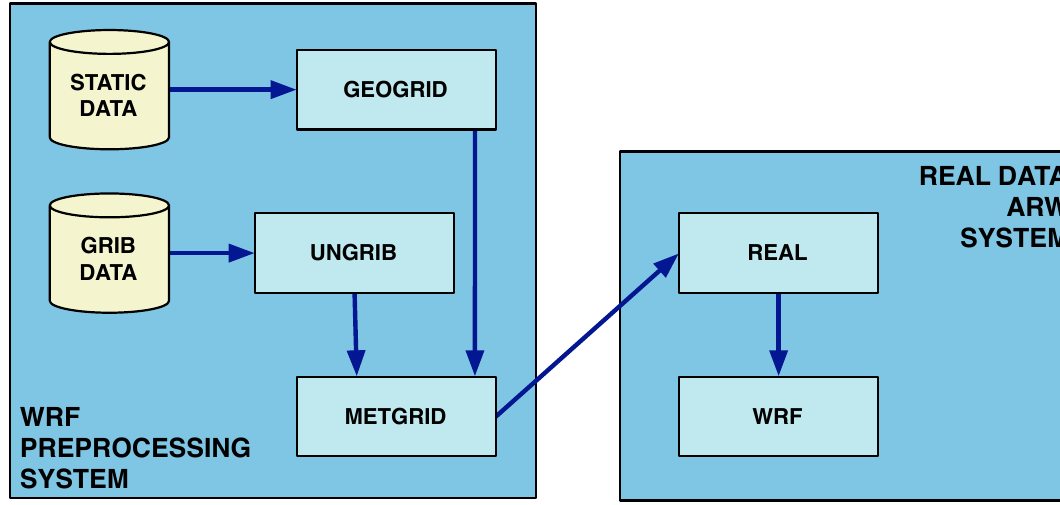
Figure 5.1: Schematic showing the data flow and program components in WPS, and how WPS feeds initial data to the ARW. Letters in the rectangular boxes indicate program names.